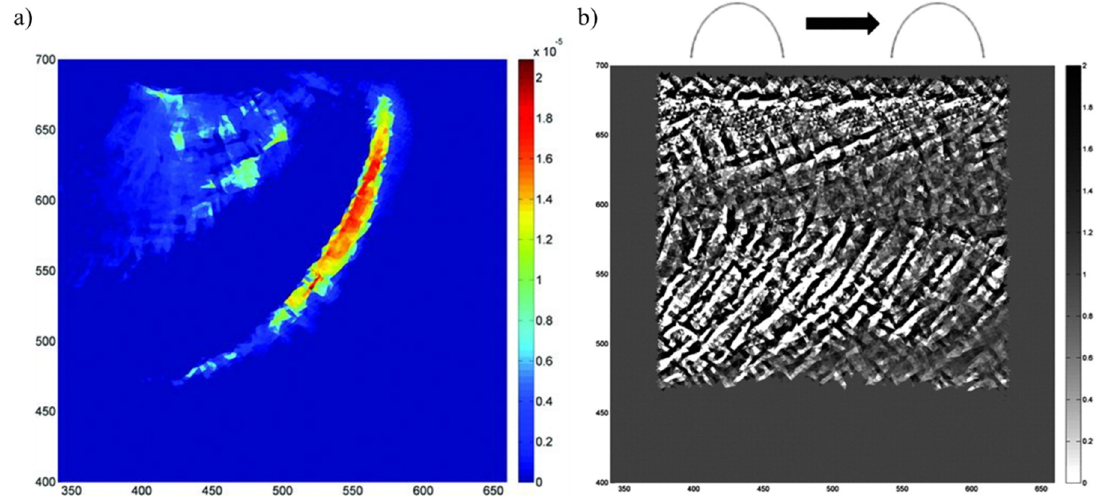
Figure 11. ( a ) Contour plot for dissipated plastic energy per unit volume; ( b ) carbon centration plot as the load moves from left to right in a 2D domain [89].